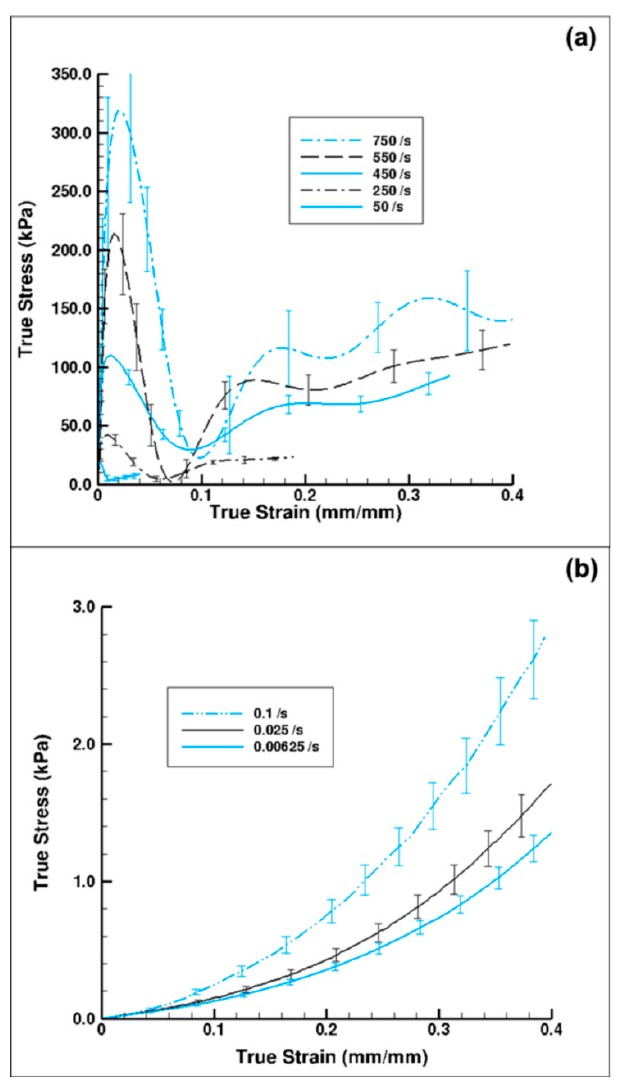
Figure 7. Comparison of ( a ) high strain rate (n = 4 (750 s − 1 ), 7 (750 s − 1 ), 5 (750 s − 1 ), 4 (750 s − 1 ), and 6 (750 s − 1 )) [29] and ( b ) quasi-static strain rate wet-brain material behavior (n = 16 (0.1 s − 1 ), 7 (0.025 s − 1 ), and 6 (0.00625 s − 1 )). The water content in the wet brain sample was ~80% m / m. Note the lower stress values for the quasi-static wet brain case and that the initial peak in stress observed under high-rate loading was not present in the quasi-static loading. The error bars represent standard error.